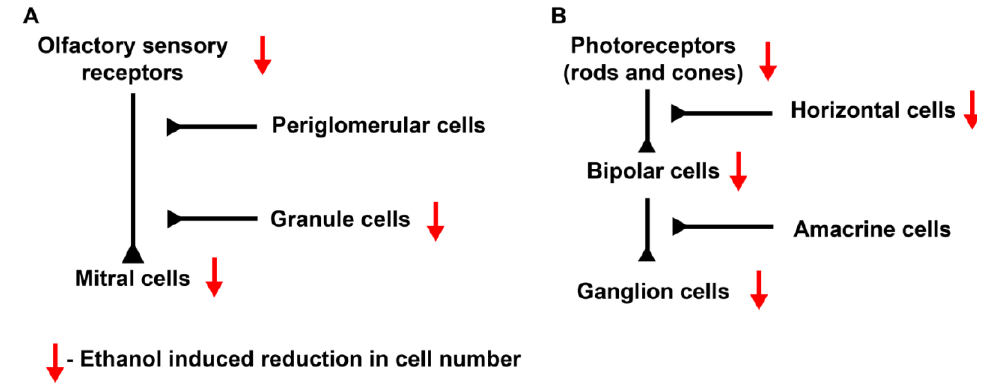
Figure 2. Effects of ethanol on olfactory and optic neuroplacodes. ( A ) Under normal conditions, olfactory sensory receptors synapse on to mitral/tufted cells in the glomeruli. This synapse can be modulated by two types of interneurons, namely periglomerular and granule cells. Studies have shown a reduction in the number of olfactory sensory neurons (OSNs), M/T cells and granule cells after ethanol treatment. ( B ) Normal development of the optic system produces various cell types in the retina. Photoreceptors synapse on bipolar cells, which then synapse on retinal ganglion cells. This circuit is modulated by interneurons, namely horizontal and amacrine cells. Ethanol reduced the number of rod photoreceptors, bipolar and ganglion cells. Horizontal cell dendrite arborization was also reduced by ethanol exposure. Black schematic synapses indicate a simplified synapse circuit. Red arrows indicate effects of ethanol on cell